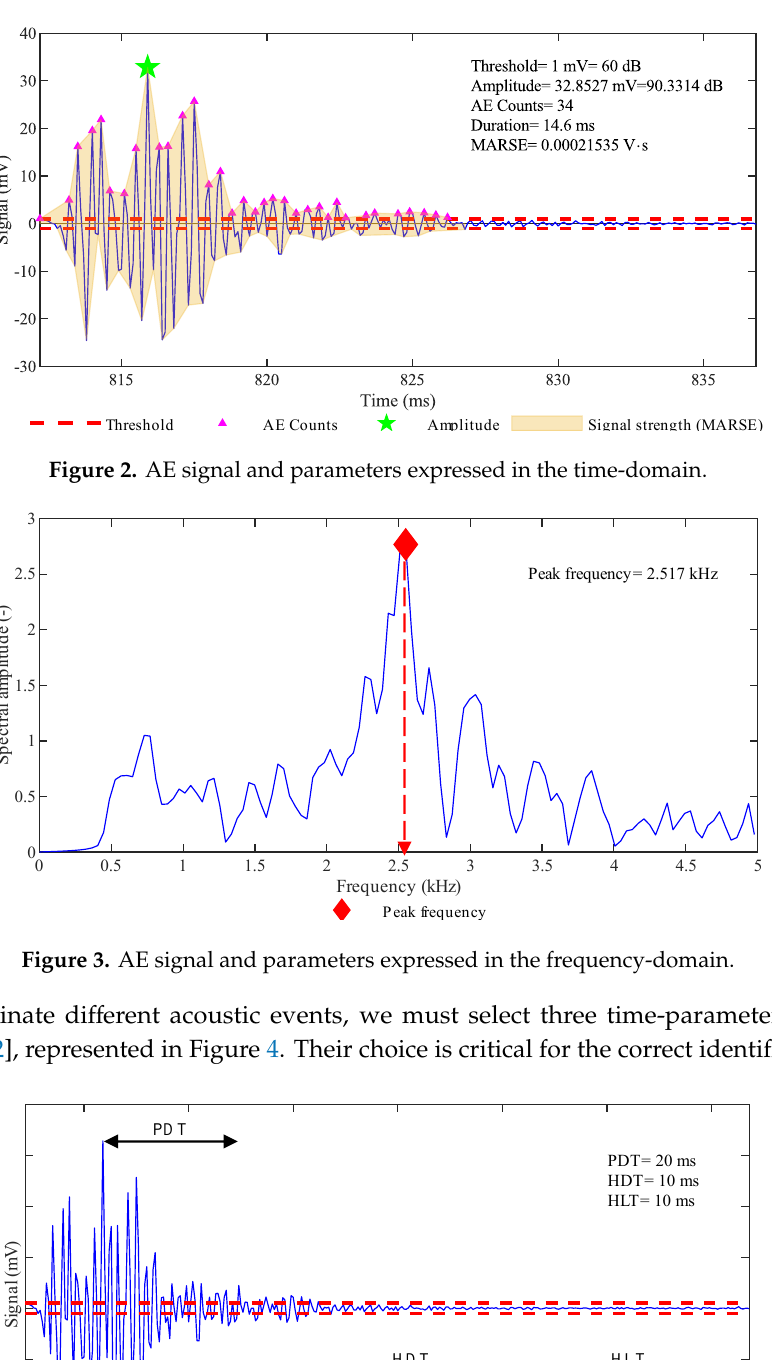
Figure 2. AE signal and parameters expressed in the time-domain.